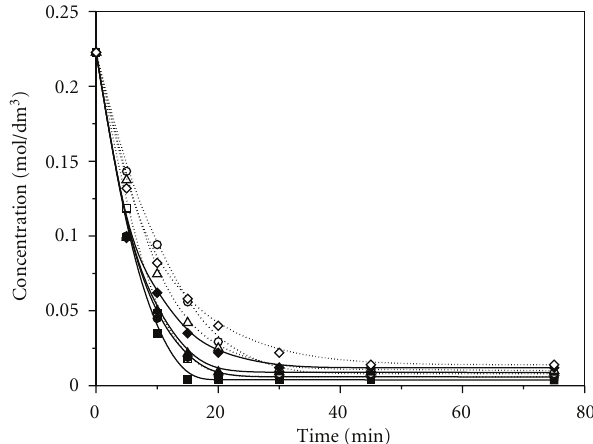
Figure 3: Change of the allicin concentration under the influence of ultrasound at 45 ◦ C and 55 ◦ C ( (cid:2) Acetonitrile 55 ◦ C; (cid:5) Acetonitrile 45 ◦ C; • Acetone 55 ◦ C; ◦ Acetone 45 ◦ C; (cid:3) Methanol 55 ◦ C; (cid:4) Methanol 45 ◦ C; (cid:4) Chloroform 55 ◦ C; ♦ Chloroform 5 ◦ C).